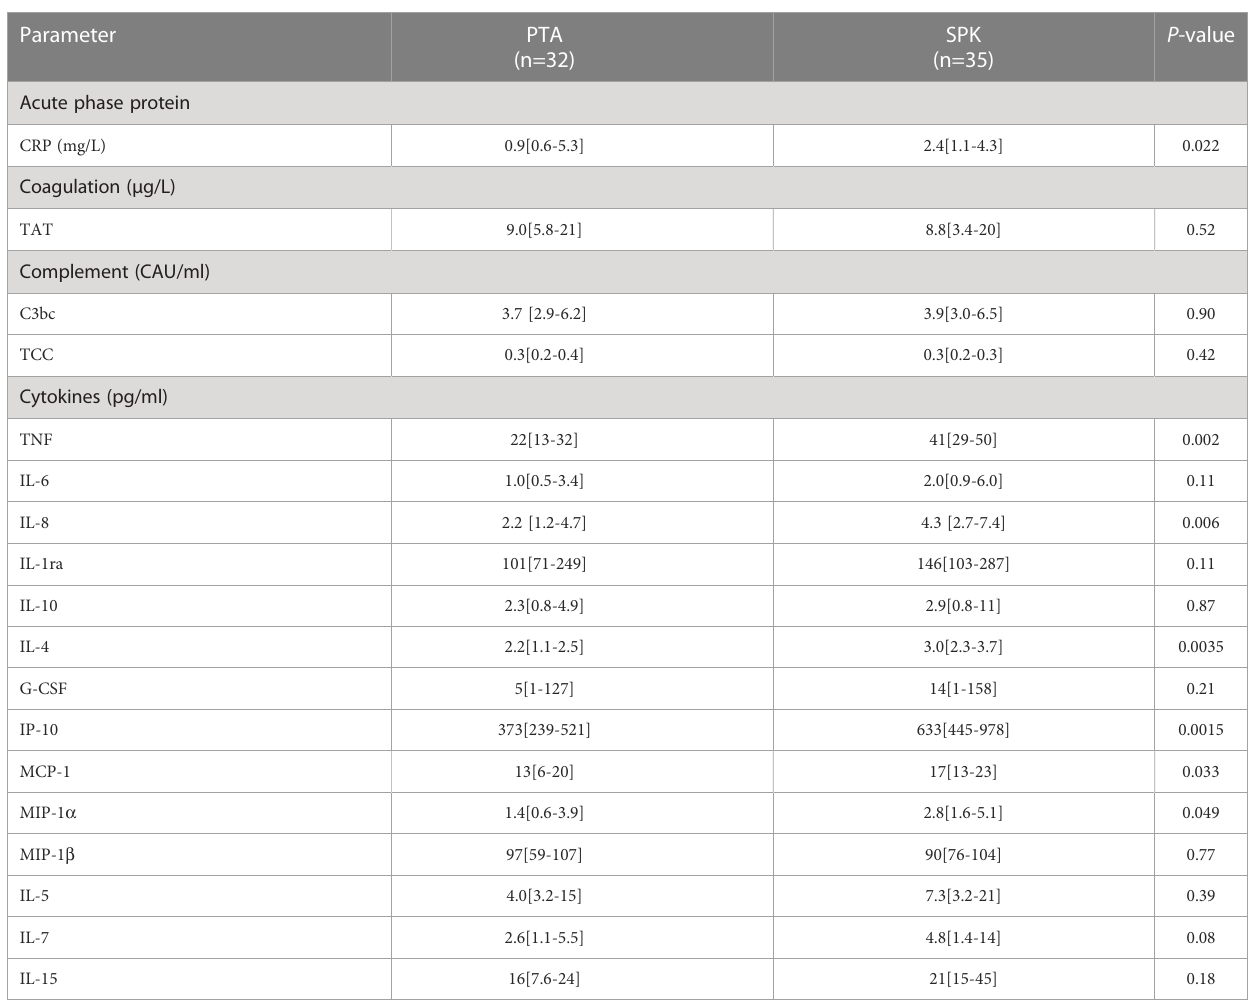
TABLE 3 Preoperative in fl ammatory parameters in PTA and SPK